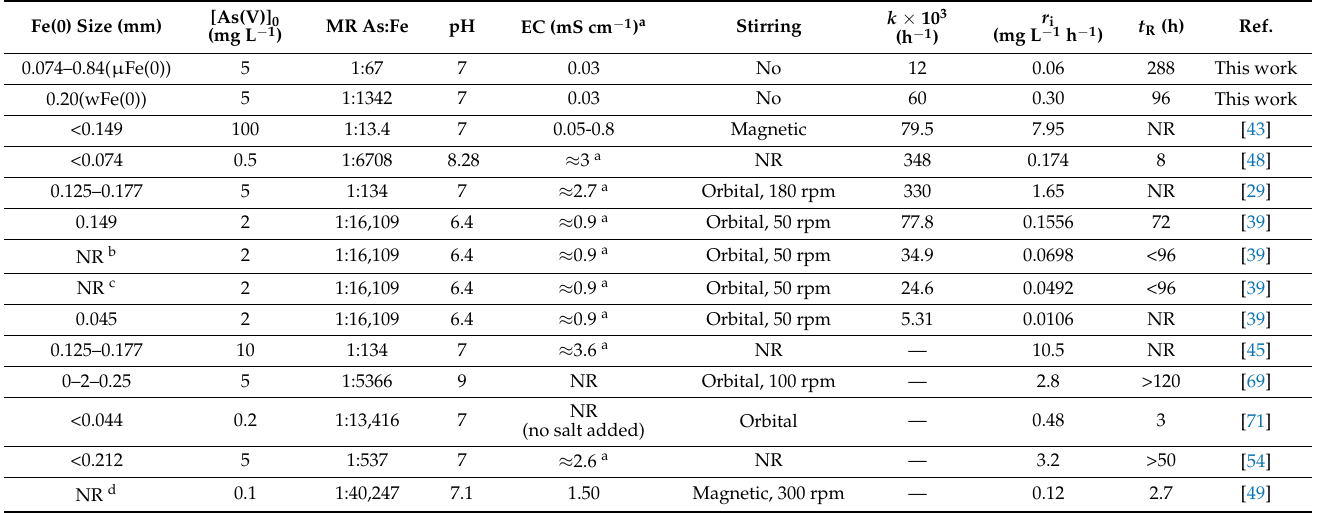
Table 2. Comparison of kinetic parameters k , r i , and t R for As(V) removal with Fe(0) under oxic